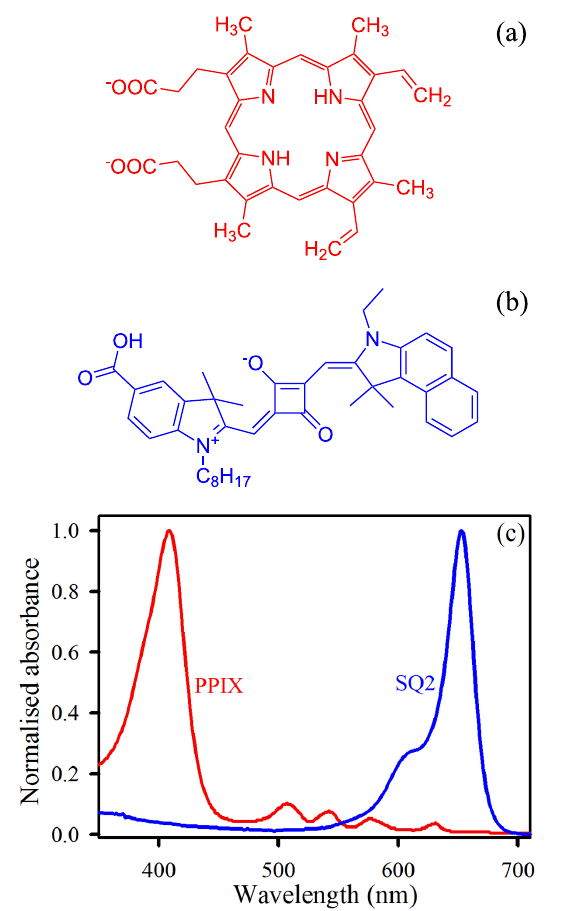
Figure 1: Structure of (a) PPIX and (b) SQ2; (c) normalized absorp- tion spectra of PPIX in DMSO and SQ2 in ethanol.